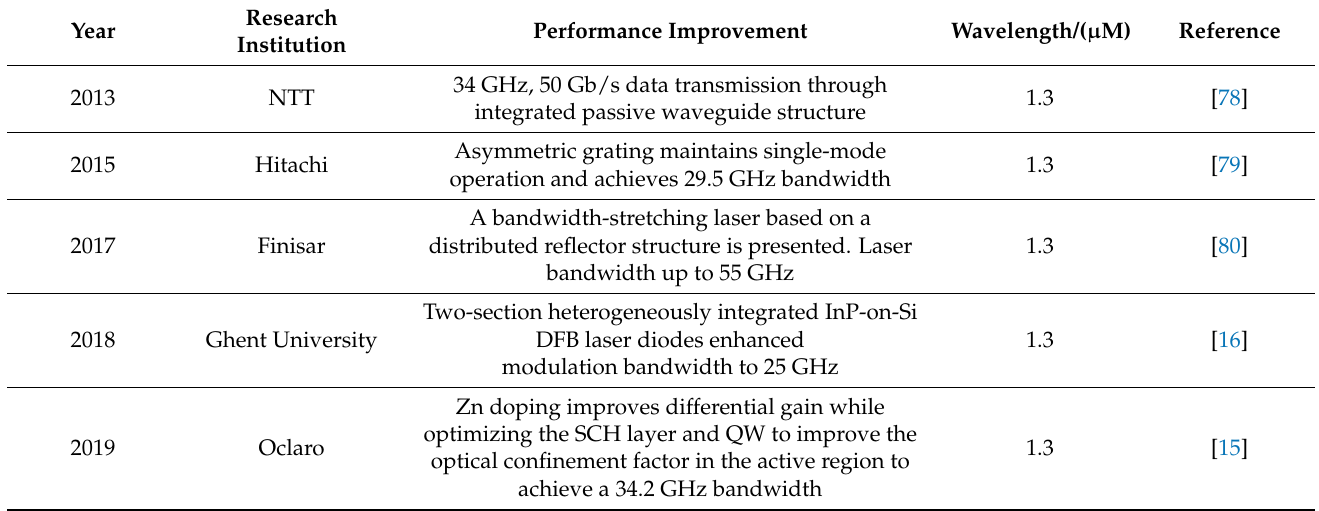
Table 2. Part of the technology to improve the modulation characteristics of